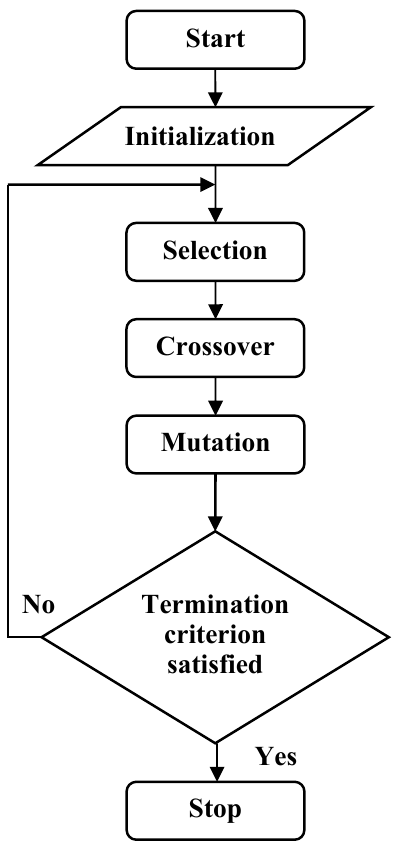
Figure 2. The flow chart of GEP.